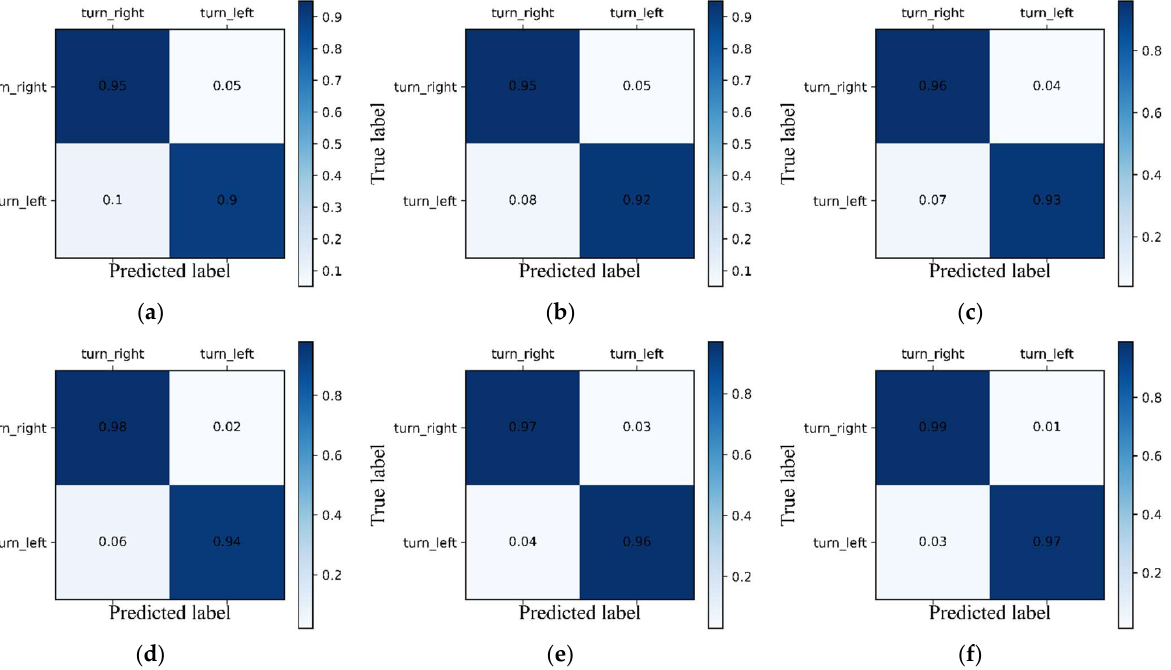
Figure 17. Confusion matrix. ( a ) XGBoost_moment, ( b ) LightGBM_moment, ( c ) Stacking fusion model_moment, ( d ) XGBoost_history, ( e ) LightGBM_history, ( f ) Stacking fusion model_history.